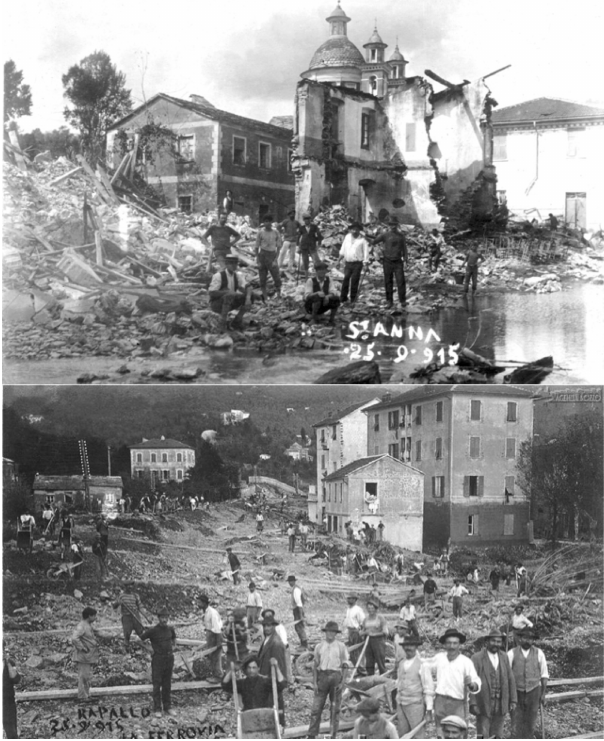
Figure 6. Rapallo flash-flood impacts on 25 September 1915 (cour- tesy of the real estate agency Bozzo in Camogli).